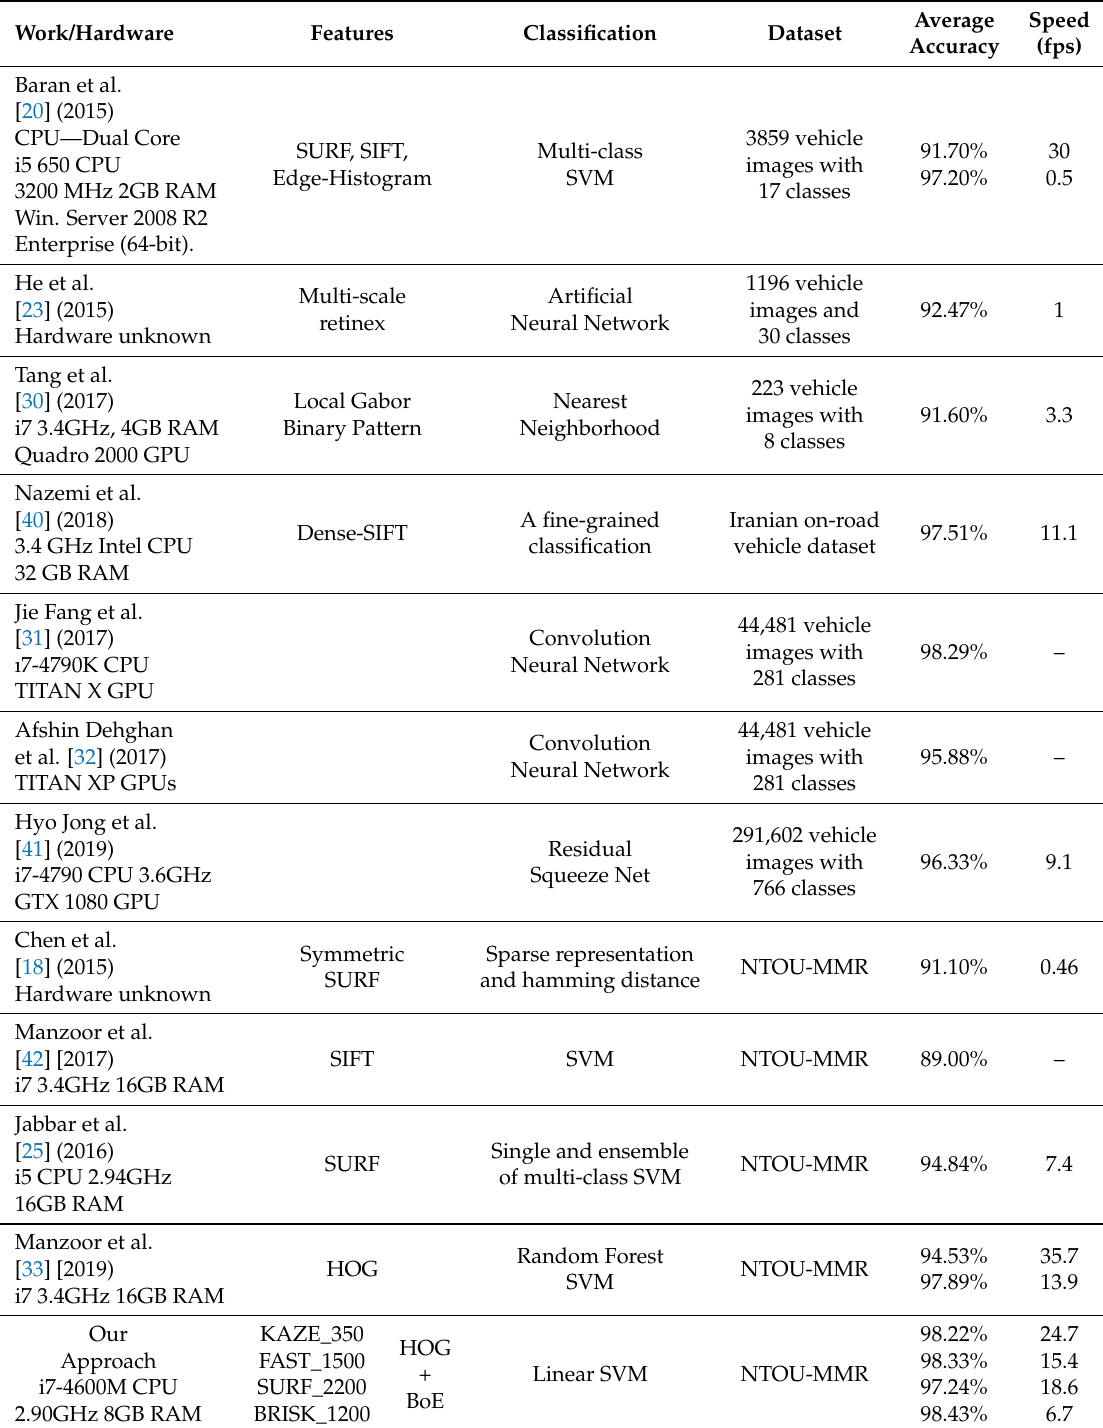
Table 6. Comparison with state-of-the-art